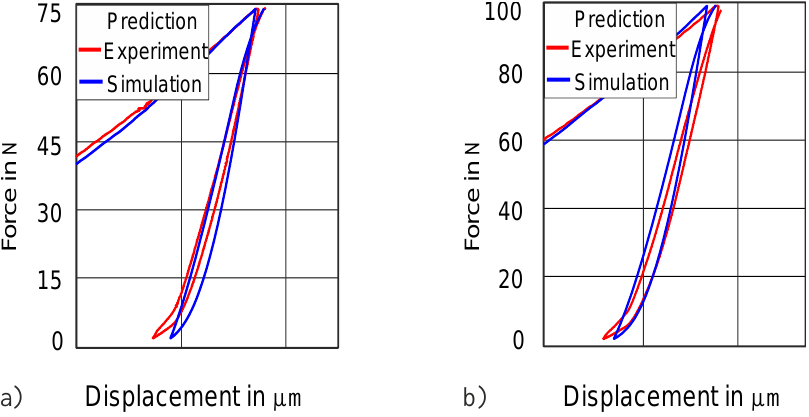
Figure 9. Validation of the method at higher force amplitudes: ( a ) predicted force – displacement at 75 N; ( b ) predicted force – displacement at 100 N.